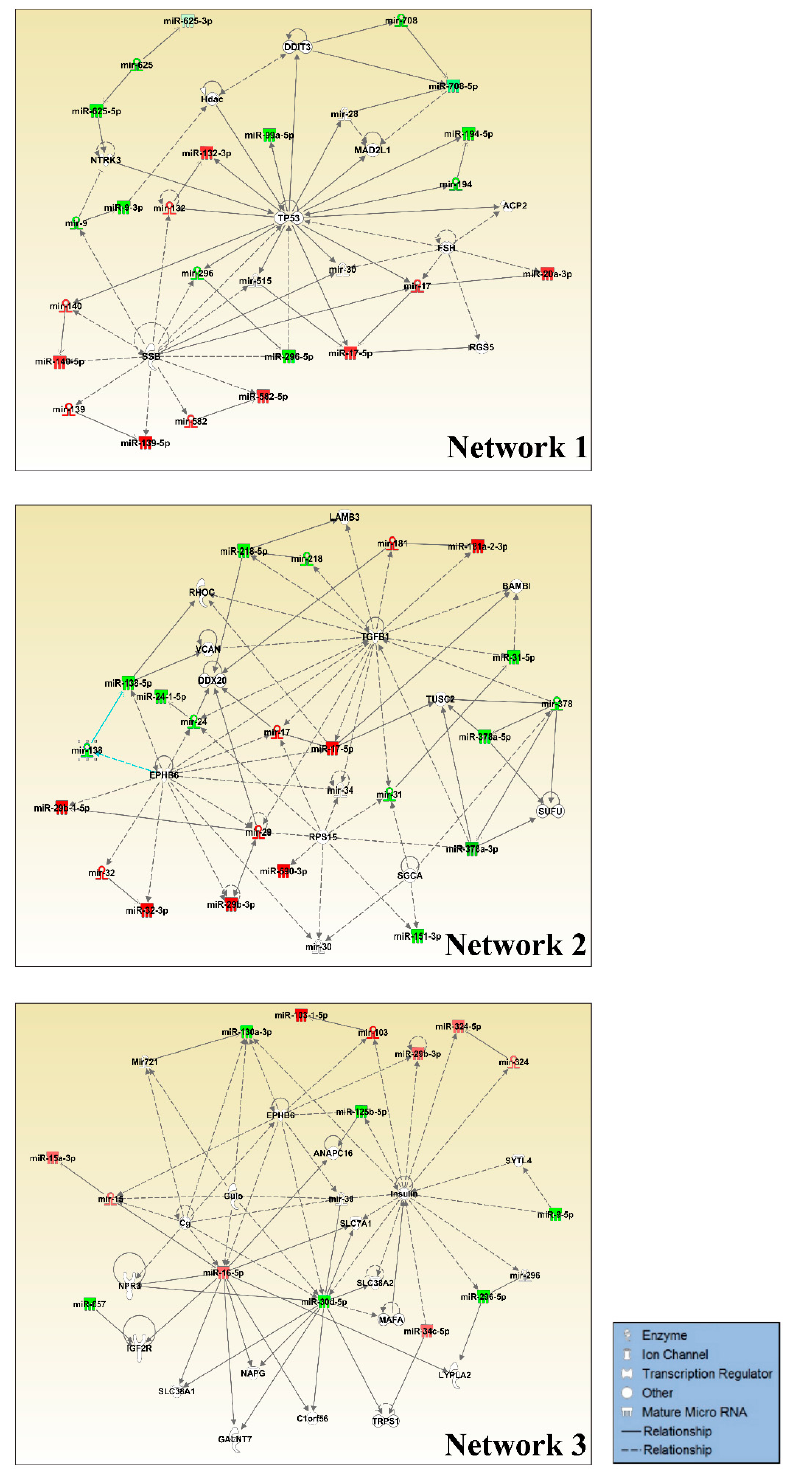
Figure 2. Molecular networks enriched by miRNAs differentially expressed in H1299/mutant p53 R273H cells. Ingenuity Pathway Analysis (IPA) generated top three significantly enriched regulatory networks of mutant p53 R273H regulated miRNAs. The networks illustrate direct or indirect interactions between altered miRNAs and their target genes. Only the highlighted (green / red) miRNAs were present in our dataset. Green and red represent down-regulated and up-regulated miRNAs,